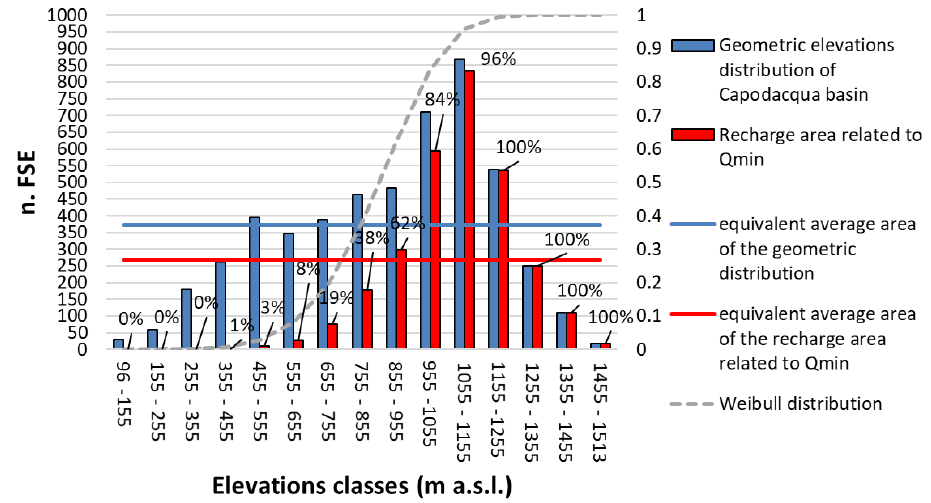
Figure 8. Maximum and minimum recharge area distribution defined by model.